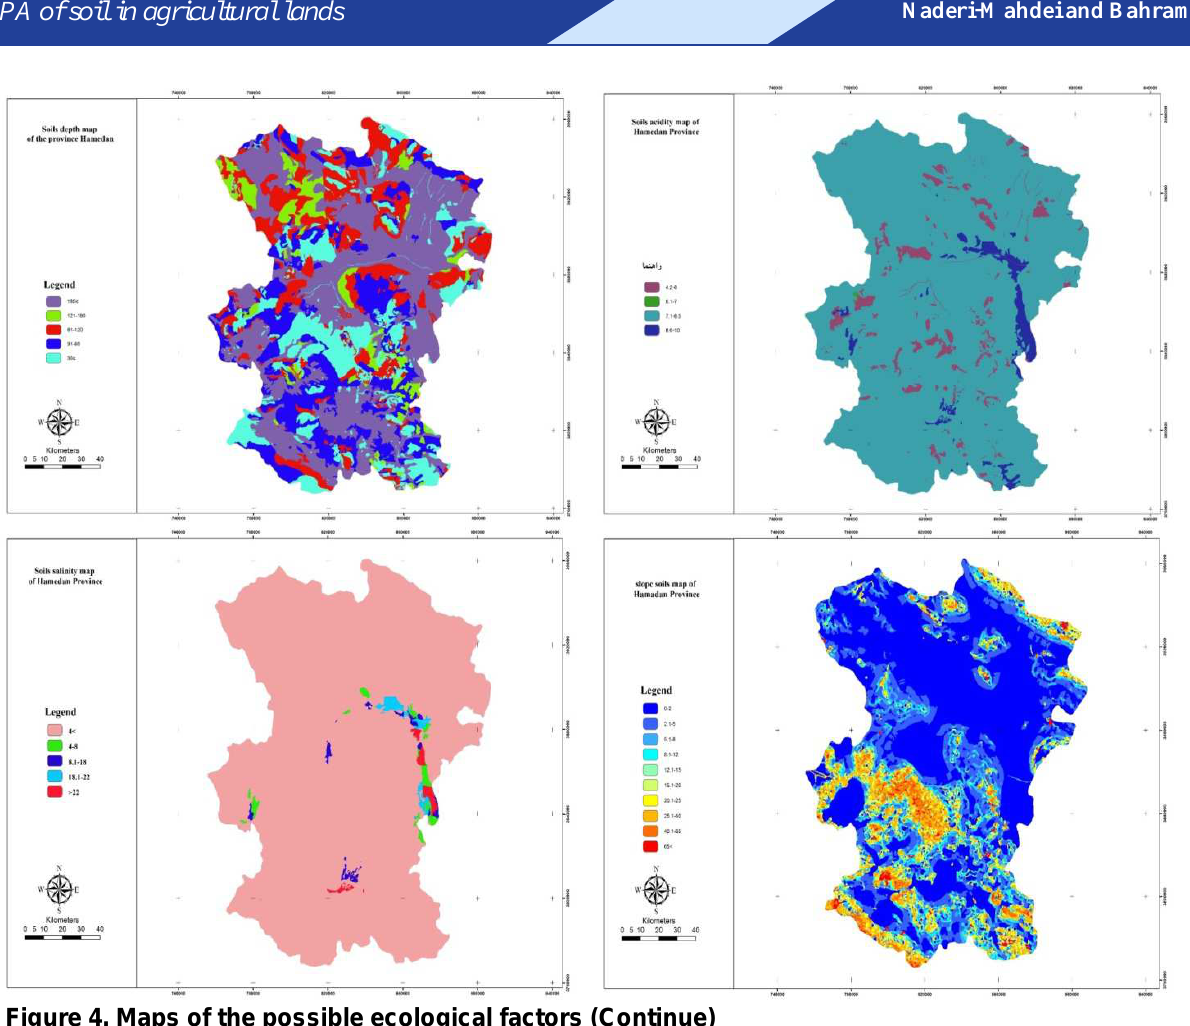
Figure 4. Maps of the possible ecological factors